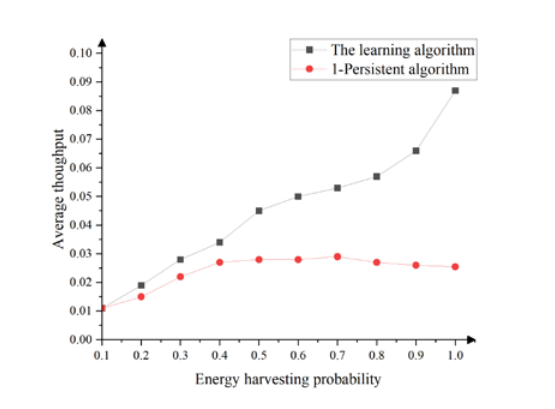
Fig. 2. The average throughput of the ST under various energy harvesting probability settings.